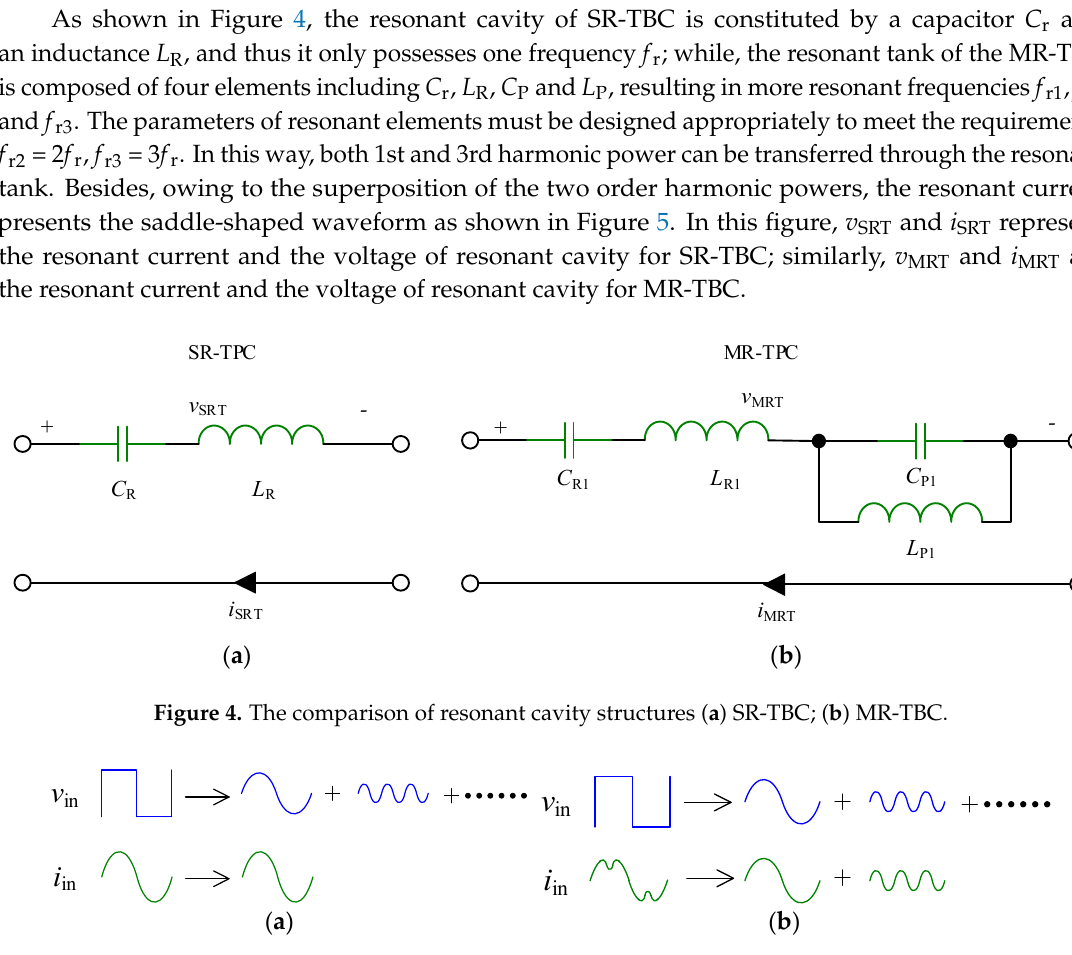
Figure 5. The comparison of resonant cavity current and voltage ( a ) SR-TBC; ( b ) MR-TBC.